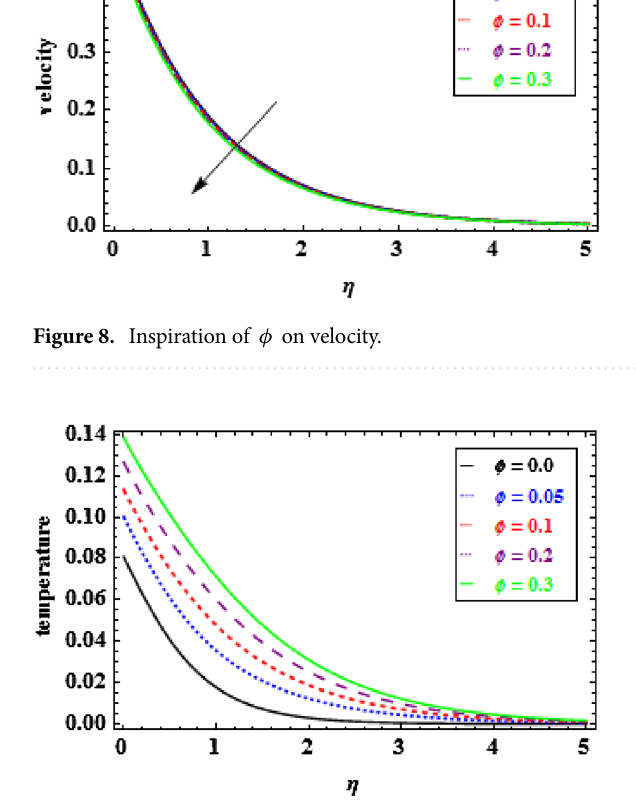
Figure 9. Inspiration of φ on temperature.